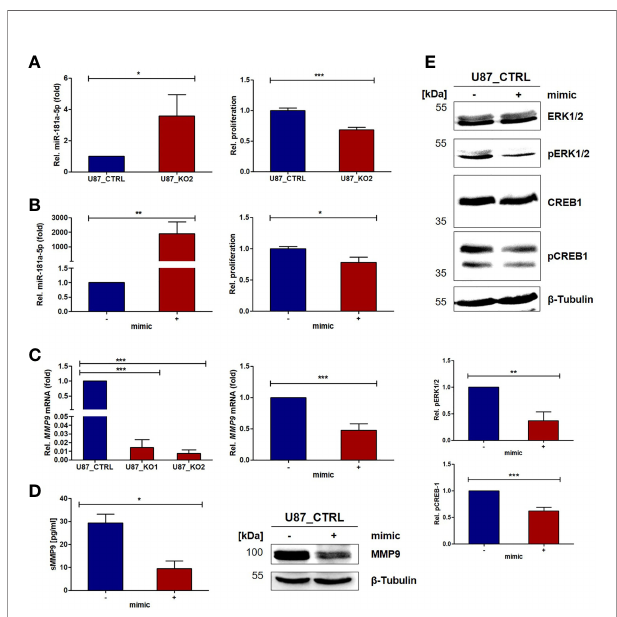
FIGURE 3 | ADAM8 affects MMP9 expression and proliferation via miR- 181a-5p targeting ERK2 and CREB-1. (A) The upregulation of miR-181a-5p in U87_KO cells (RT-qPCR, n=3, left) causes inhibition of proliferation (CellTiter Glo, n=2, measurement after 48 h, right). (B) Overexpressing miR- 181a-5p in U87_CTRL cells via transient transfection (RT-qPCR, n=3, left) causes inhibition of proliferation after 48 h (CellTiter Glo, n=3 technical replicates, right). (C) MMP9 is downregulated in U87_KO cells on mRNA (RT- qPCR, n=3, left). After miR-181a-5p mimic transfection, MMP9 is downregulated in U87 cells on the mRNA (RT-qPCR, n=3, p-value: 0.0009) (C) and on protein level (ELISA, n=2, p-value: 0.0004) analyzed by western blot (D) . (E) Analyses of kinase activation after miR-181a-5p mimic transfection for ERK1/2 (p-value: 0.003) and CREB-1 (p-value: 0.0007). Results are shown as mean values +/- SD of three independent experiments unless otherwise stated. Results are given in mean +/- SD. Unpaired one-